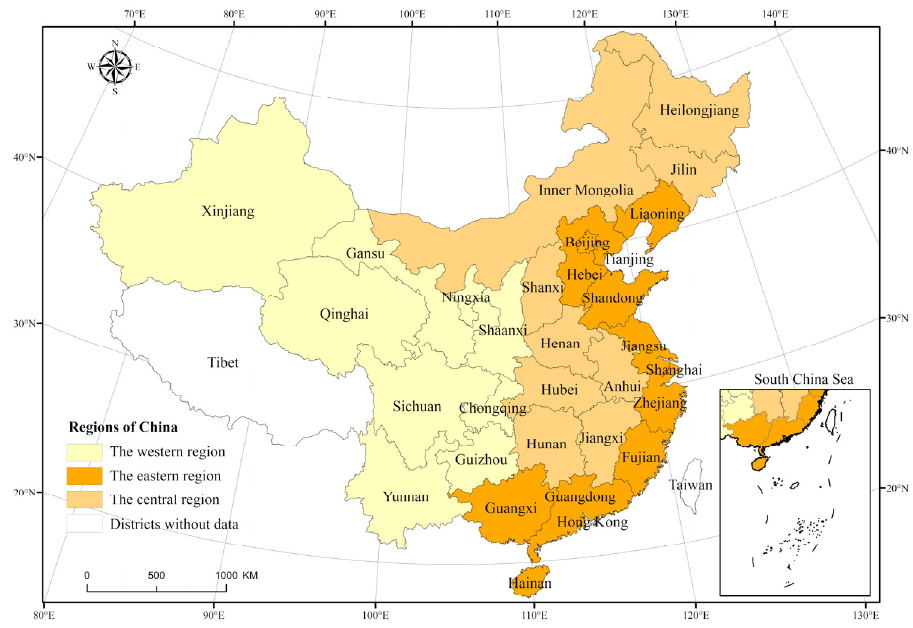
Figure 1. Three major clusters—east, central, and west of China. According to the meta-frontier model proposed by Battese (2004) [50], the set of tech- nologies under the meta-frontier ( meta T ) is constructed as follows.